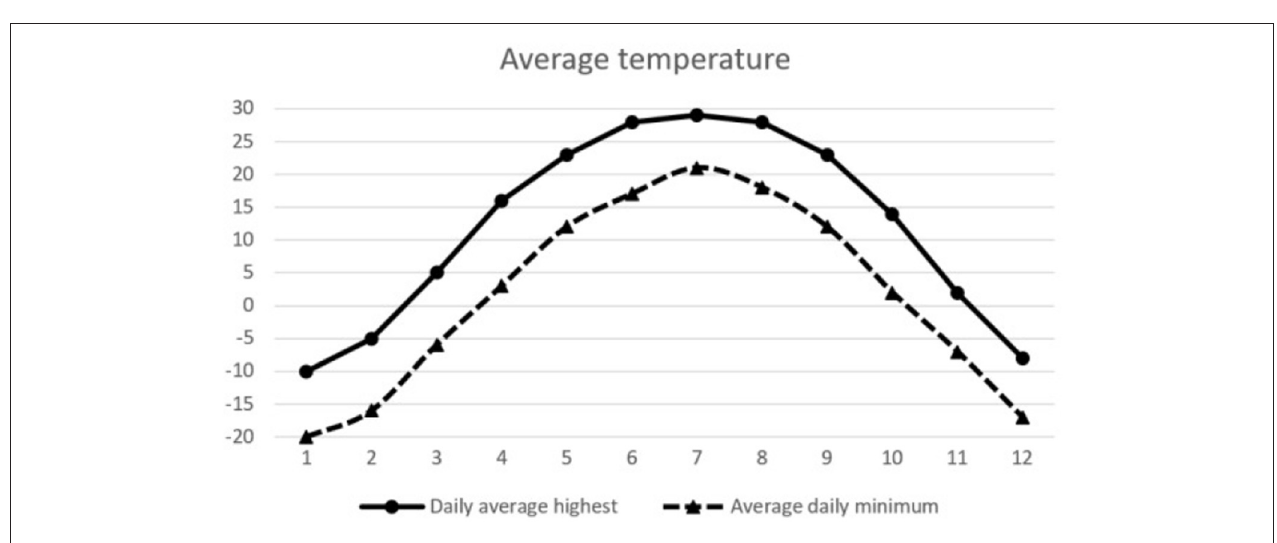
FIGURE 2 | Daily average temperature chart.